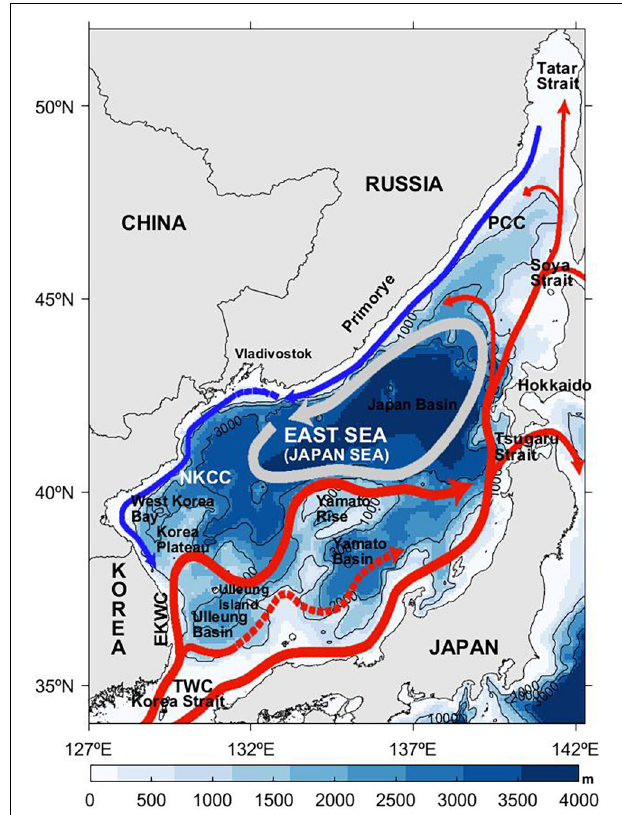
FIGURE 1 | Surface current system over the bathymetry (m) of the East Sea (Japan Sea). Red (blue) solid lines represent warm (cold) currents. Gray solid line indicates that surface currents are connected to deep currents. Dashed lines represent seasonal differences and highly variable spatial distributions. EKWC, East Korea Warm Current; NKCC, North Korean Cold Current; PCC, Primorye Cold Current; TWC, Tsushima Warm Current. The current map is from Park et al.